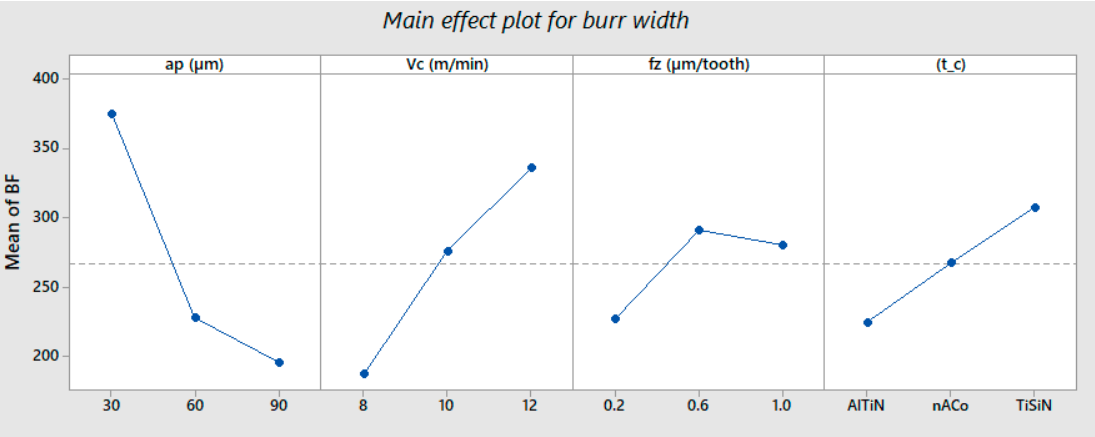
Figure 6. Main effect plot for burr width.